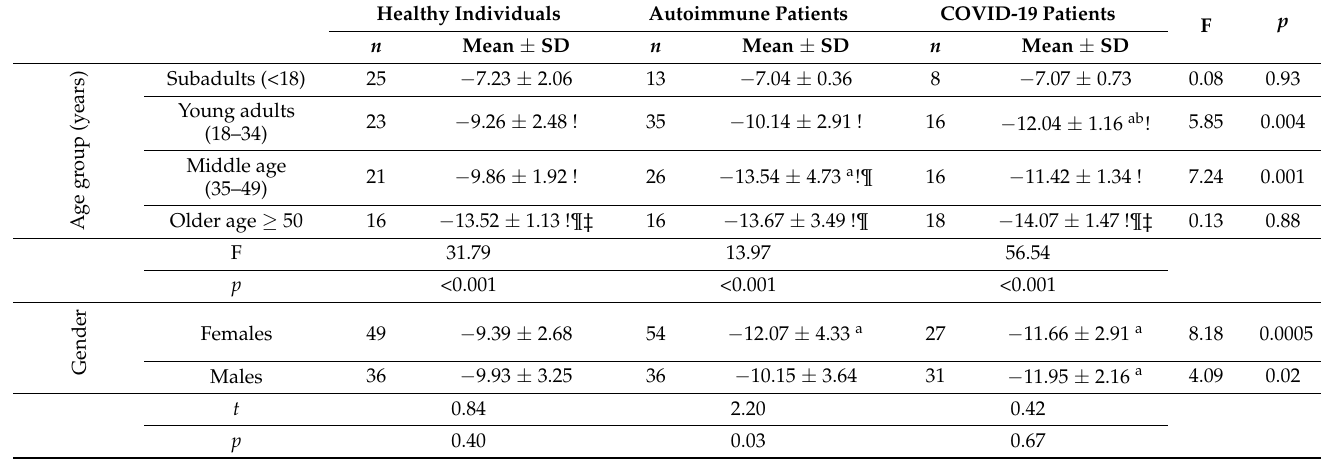
Table 2. Comparisons of sjTRECs levels (mean dCt values) between the healthy group, autoimmune patients, and COVID-19 patients, according to their gender and age .